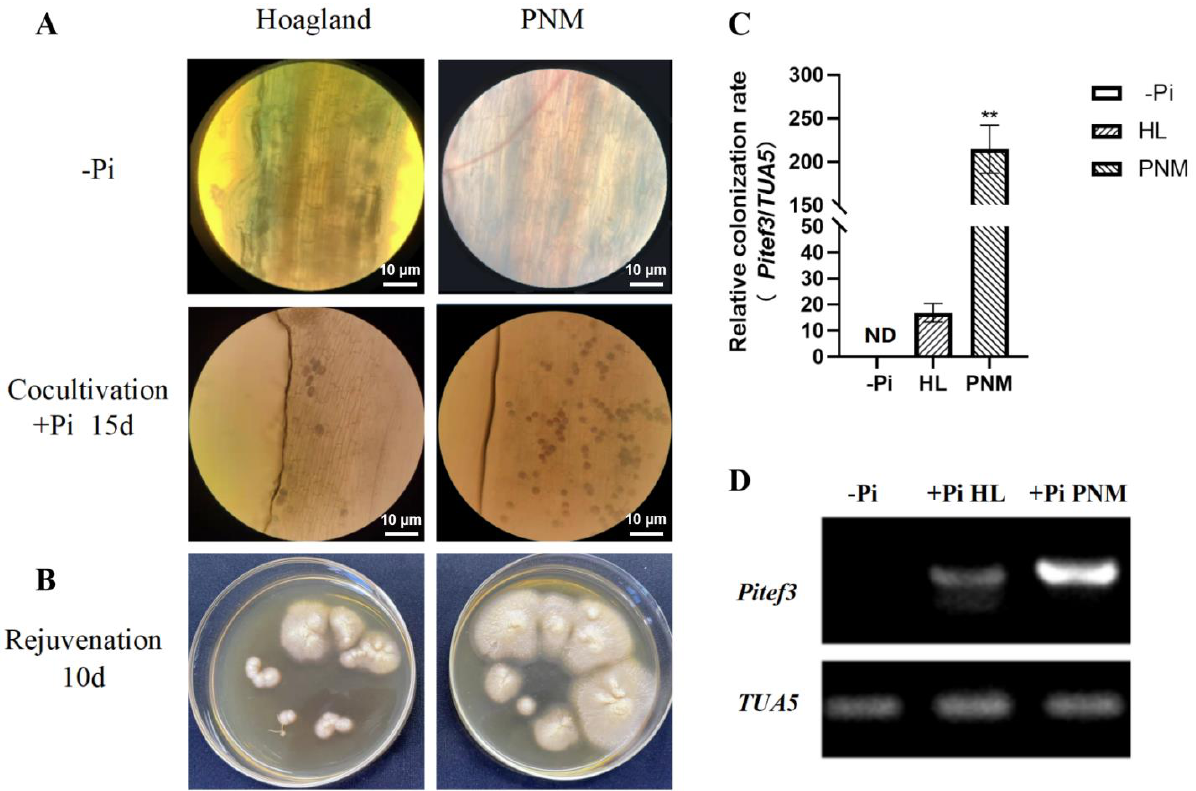
Figure 1. Differences in the colonization of Piriformis indica in PNM and Hoagland media. ( A ) typical trypan blue detection result of P. indica -colonization in soybean root (light microscope, magnification 200 × scale, the scale bar indicates 10 µ m). ( B ) The rejuvenation of symbiotic P. indica (colonized roots from PNM or Hoagland medium grown for 10 days in PDA media). ( C ) Molecular identification of the marker gene Pitef1 in P. indica -colonized soybean lateral roots between PNM or Hoagland (HL) media by qRT-PCR and ( D ) RT-PCR. ND: non-detection. +Pi: P. indica - colonized. −Pi: non - colonized plants. GmTAU5 was an internal reference gene. The values are the means ± SDs of three replicates; ** indicates an extremely significant difference ( p < 0.001).